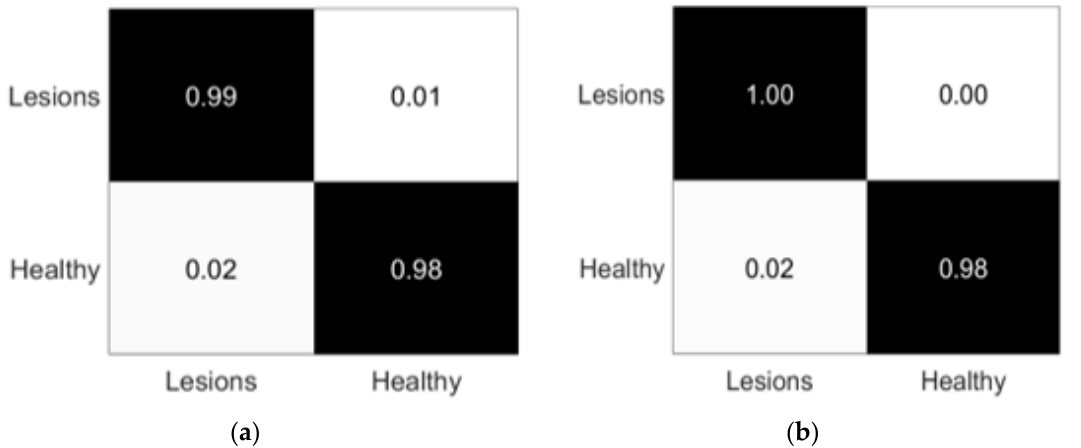
Figure 11. Confusion matrix shows the lesion segmentation results in ( a ) liver, and ( b ) liver tumor. As seen in Figures 12 and 13, the proposed model more correctly splits the actual liver tumour lesions.